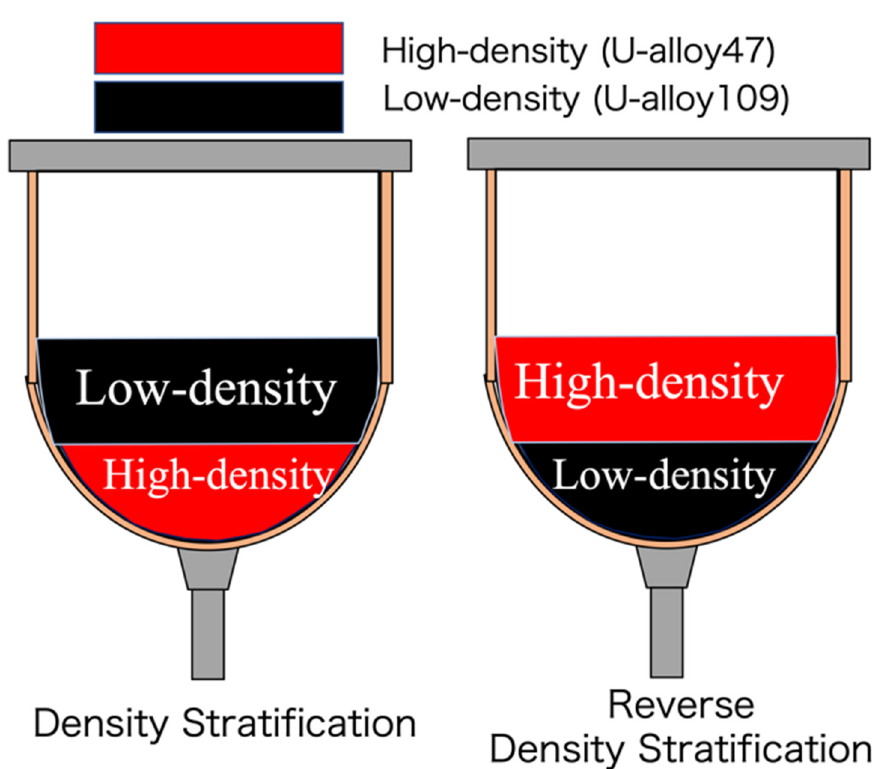
Figure 3. The arrangement of the simulants in the vessel.